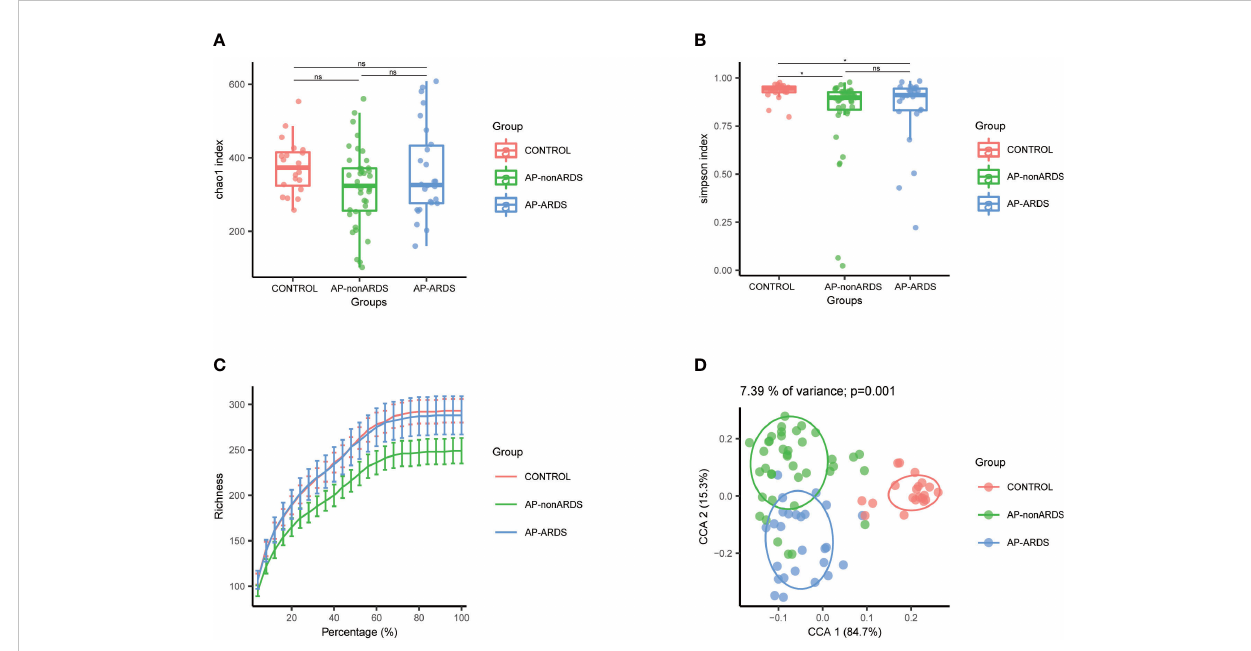
FIGURE 1 Diversity analysis of Control, AP-nonARDS and AP-ARDS group. (A) Chao index of a analysis; (B) Simpson index of a analysis. There are signi fi cant differences between the Control group and AP patients, but no signi fi cant difference between AP-nonARDS and AP-ARDS group. (C) Rarefaction curves analysis. (D) . Principal coordinate analysis (PCoA). CONTROL, healthy population; AP-nonARDS, AP patients without ARDS; AP-ARDS, AP patients with ARDS. * P < 0.05; ns: not signi fi cant.